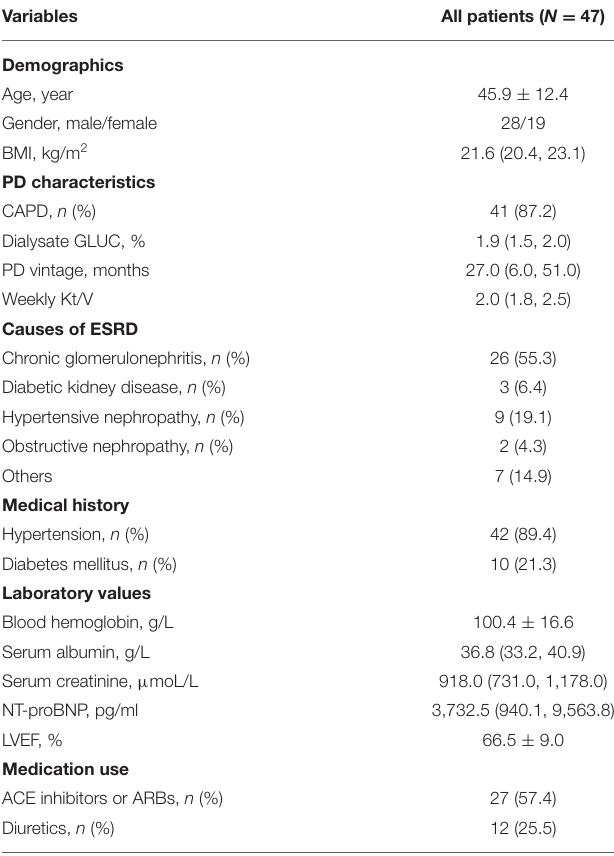
TABLE 1 | Baseline characteristics of PD patients before ARNI